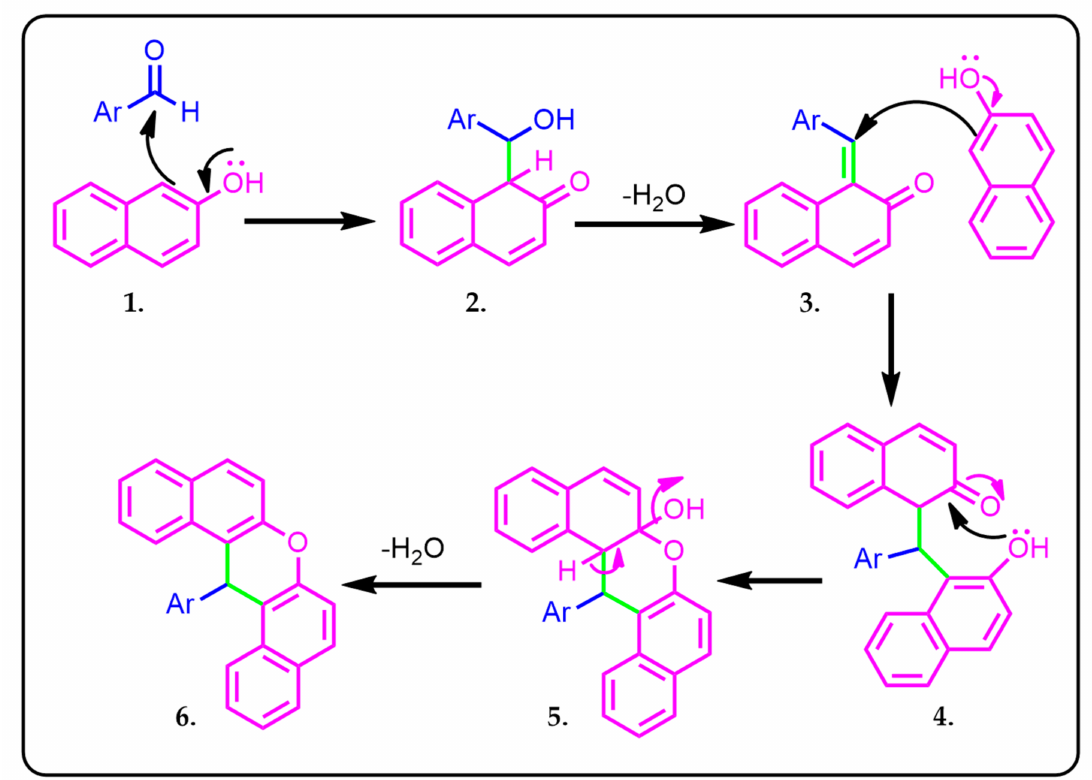
Scheme 4. Plausible reaction mechanism for the synthesis of xanthene